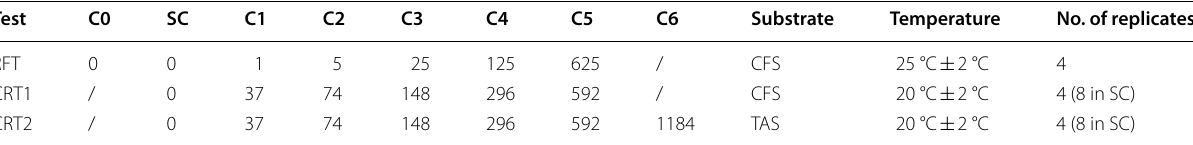
RFT range-finding test, CRT concentration–response test, C0 control without solvent, SC solvent control, C1–C6 concentrations [µg a.s./g oatmeal], CFS coconut fiber substrate, TAS tropical artificial